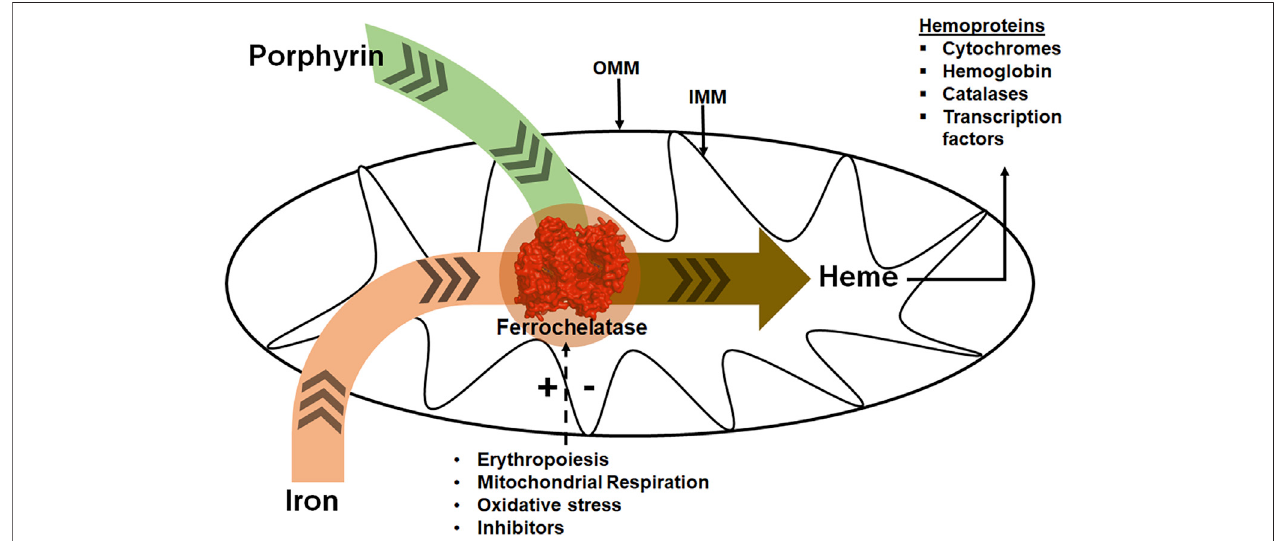
FIGURE 1 | Ferrochelatase at the intersection of iron and porphyrin metabolism in mitochondria. Ferrochelatase (colored red) in the mitochondrial matrix catalyzes the insertion of ferrous iron into protoporphyrin IX to produce heme. Synthesized heme is then traf fi cked to hemoproteins. Physiological conditions such as erythropoiesis, mitochondrialrespiration, and oxidativestressregulatethis process. (+)and ( − ) signs represent stimulation or inhibition offerrochelatase activity bythese physiological conditions and dashed arrow represents regulatory process. IMM refers to the inner mitochondrial membrane and OMM to the outer mitochondrial membrane.